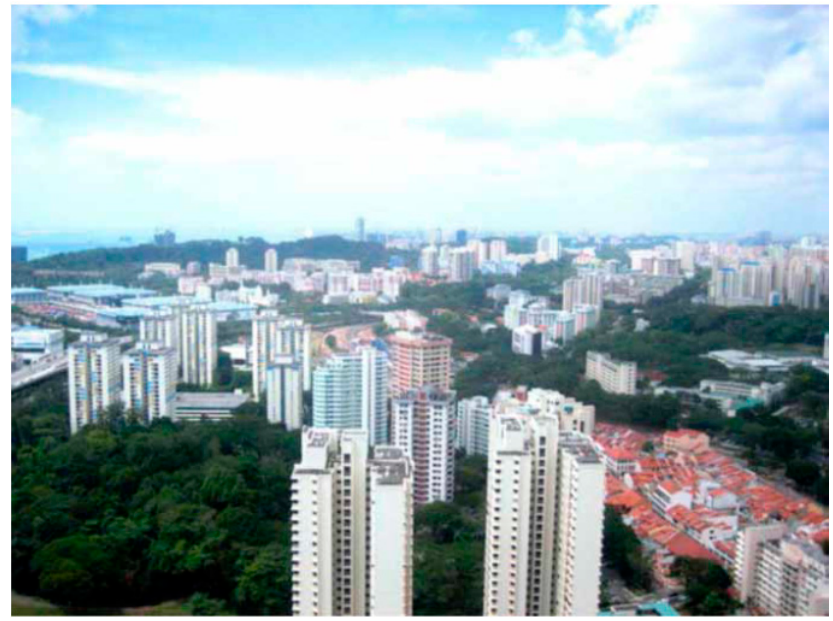
Figure 5. Singapore Garden City (source, Peter Newman). Geosciences 2016 , 6 , 46